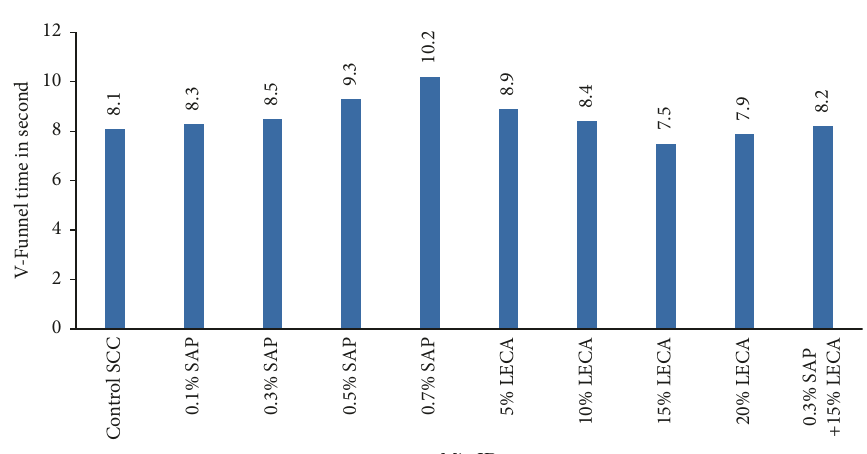
Figure 8: T-500 time of all SCC mixes.